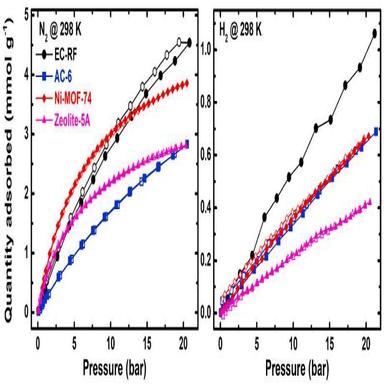
N2 and H2 adsorption (solid symbols)-desorption (open symbols) isotherms of the samples as shown measured up to 20 bar at 298 K.